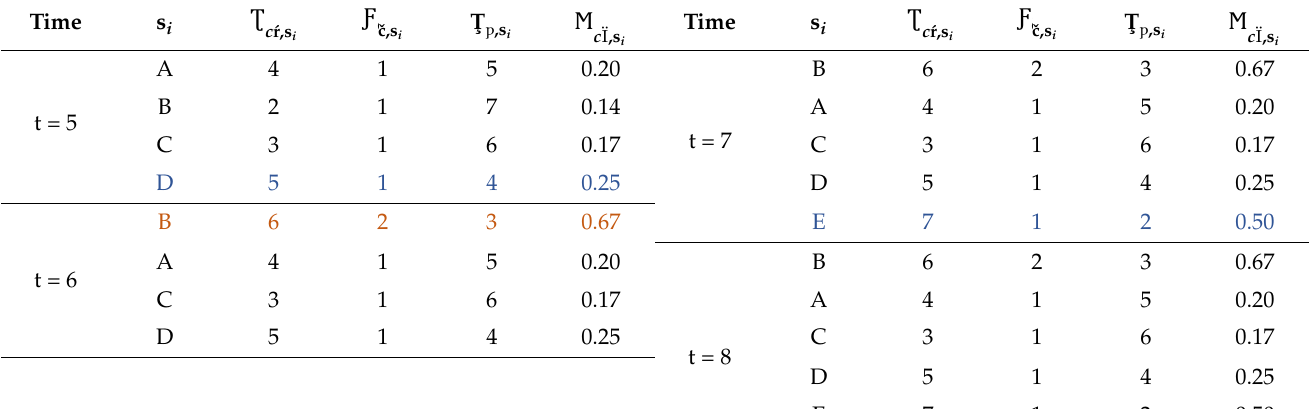
Table 4. IMU process at t = 5 to t = 8.